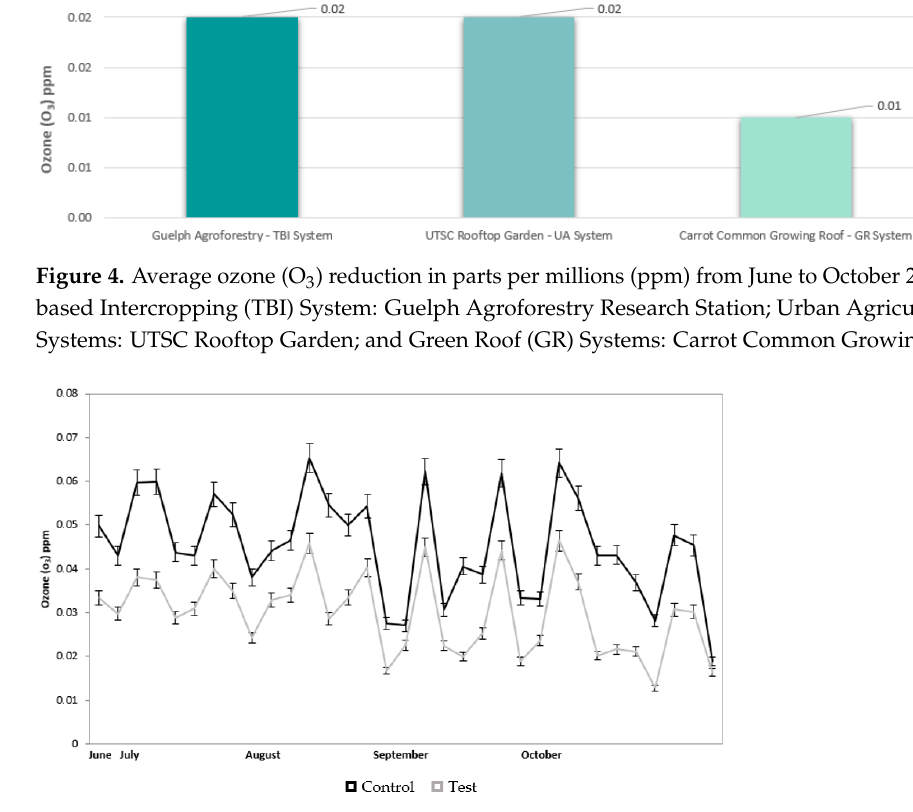
Figure 5. Daily average ozone (ppm) for test and control across all sites from June to October 2017. A t -test was conducted for the test and control pair at each site, yielding a p value below the 0.001 margin of error, indicating there is a statistically significant difference in ozone between the means of the test and control for all applications of green infrastruc- ture.